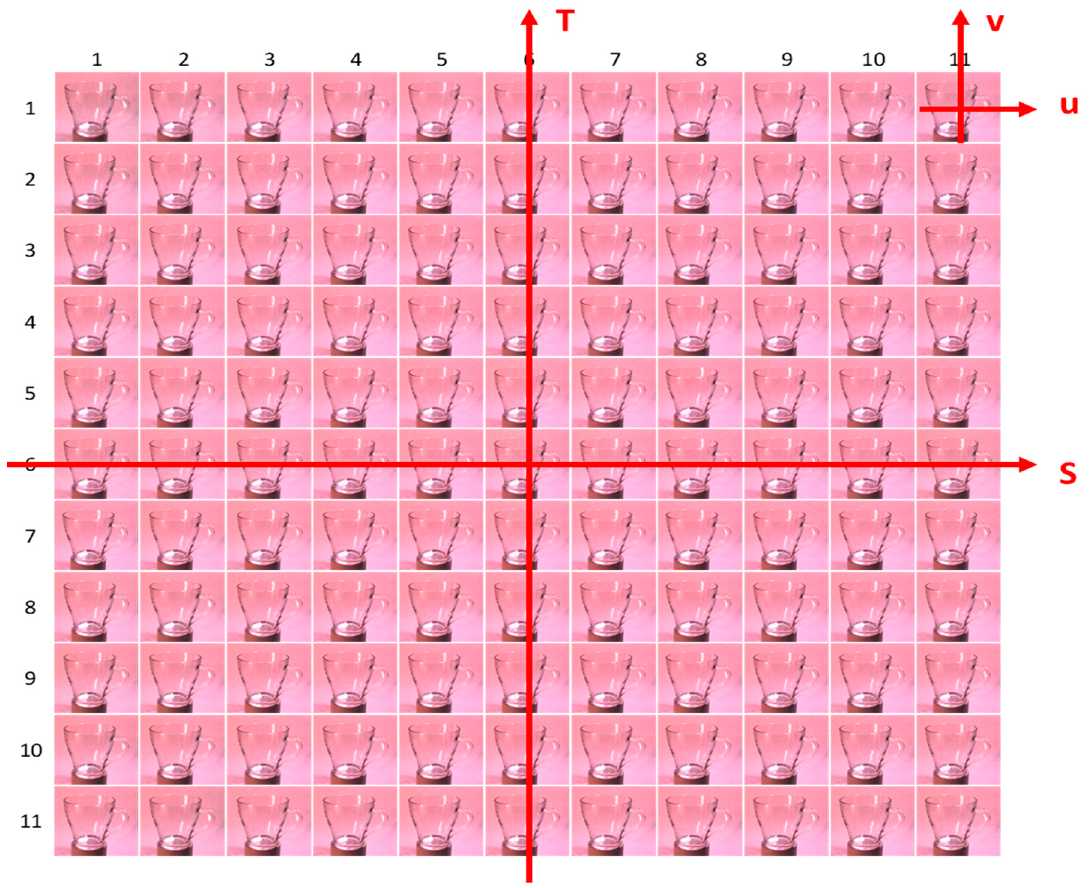
Figure 4. Captured 4D light filed images through Lytro camera (sample object O#8 with 121 sub-aperture images).